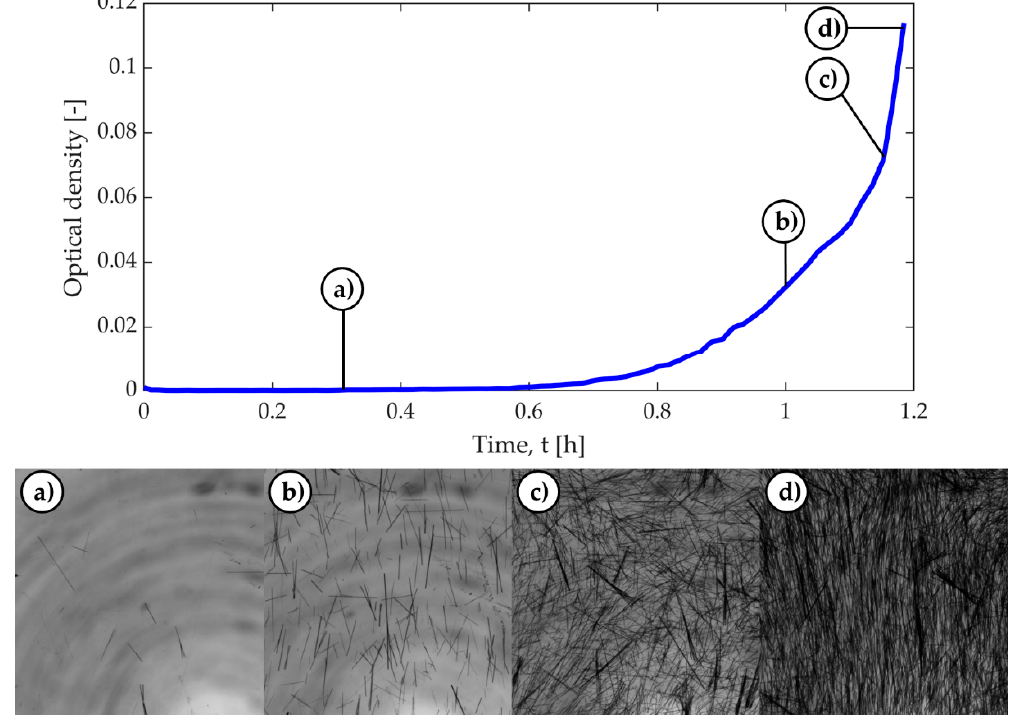
Figure 13. Optical density for the thiamine anti solvent crystallization based on pixel ratios of the shadowgraphic probe images. The images at the bottom were captured with the shadowgraphic probe at different experiment times; ( a ) t = 0.3 h first single crystals, ( b ) t = 1 h recognizable number of crystals, ( c ) t = 1.16 h first agglomerates and increased overlapping of the crystals and ( d ) t = 1.18 h last possible measurement point, afterwards the suspension density was too high to capture further images.